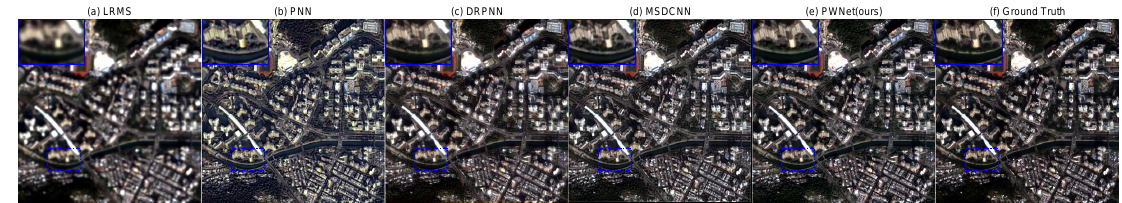
Figure 13. Visual comparison of the CNN-based methods on the QuickBird data set, ( a ) LRMS; ( b ) PNN;